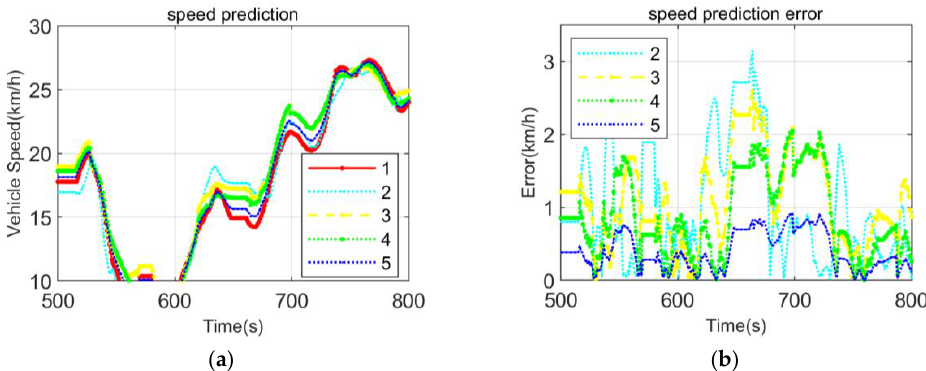
Figure 8. The speed prediction results and prediction error of four methods. ( a ) BPNN speed pre- diction; ( b ) LSSVM speed prediction; ( c ) APSO LSSVM speed prediction; ( d ) APSO LSSVM and BP NN speed prediction.